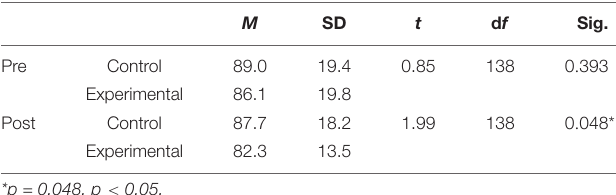
TABLE 4 | Foreign Language Test Anxiety Scale (FLTAS) paired sample T -test